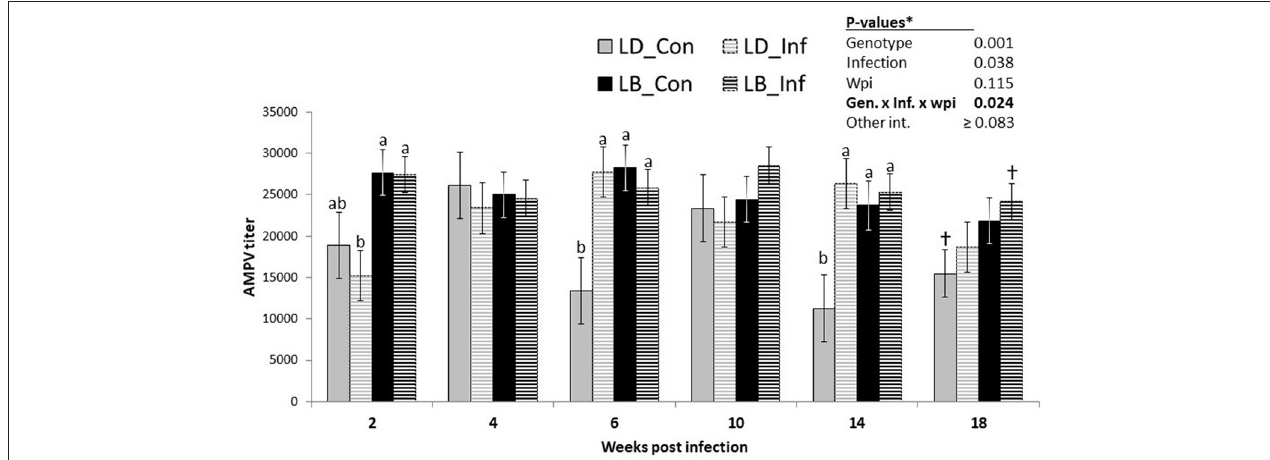
FIGURE 3 | Course of vaccine-induced Avian Metapneumovirus (AMVP) titers in nematode-uninfected (_Con) or infected (_Inf) hens of Lohmann Brown Plus (LB) and Lohmann Dual (LD) genotypes over a period of 18 weeks post-infection. ab Different letters indicate significant differences among 4 groups at a given wpi ( p < 0.05). † Groups sharing the sign tend to differ ( p = 0.068).